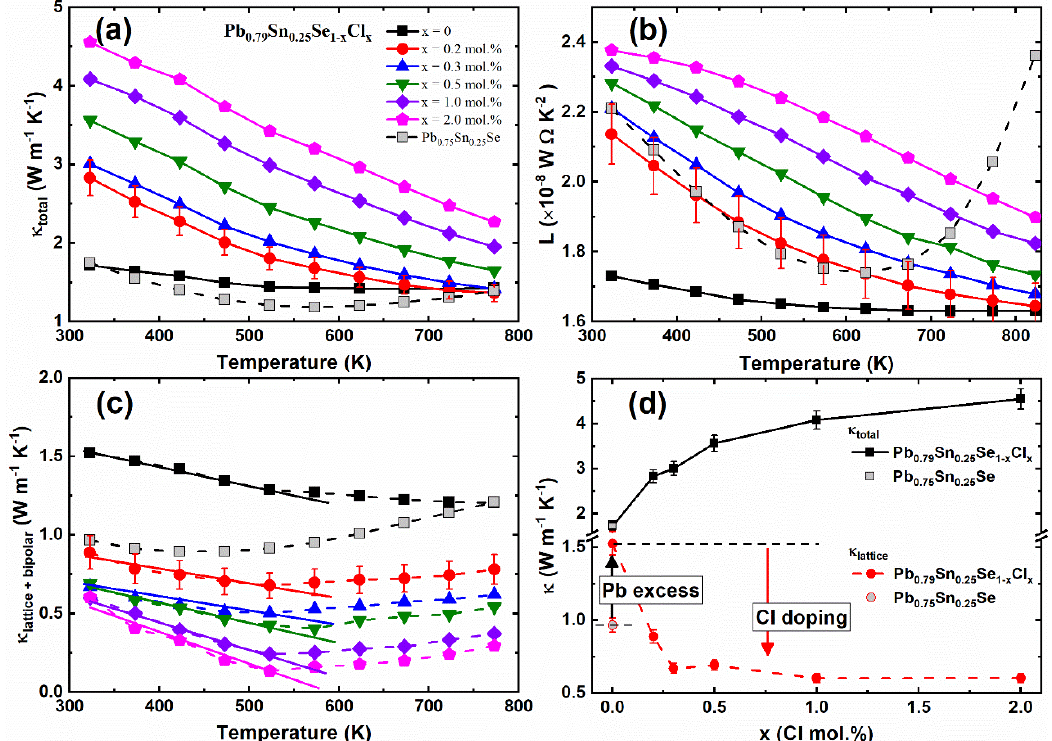
Figure 5a. Overall, the κ total of the non-Pb-excess sample (Pb 0.75 Sn 0.25 Se) was lower than the values of the Pb-excess sample (Pb 0.79 Sn 0.25 Se). The κ total of the Cl-doped Pb-excess samples